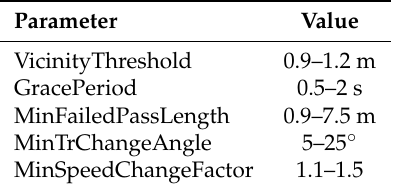
Figure 3. The influence of parameter values on event recognition quality. Table 4. Optimal parameter